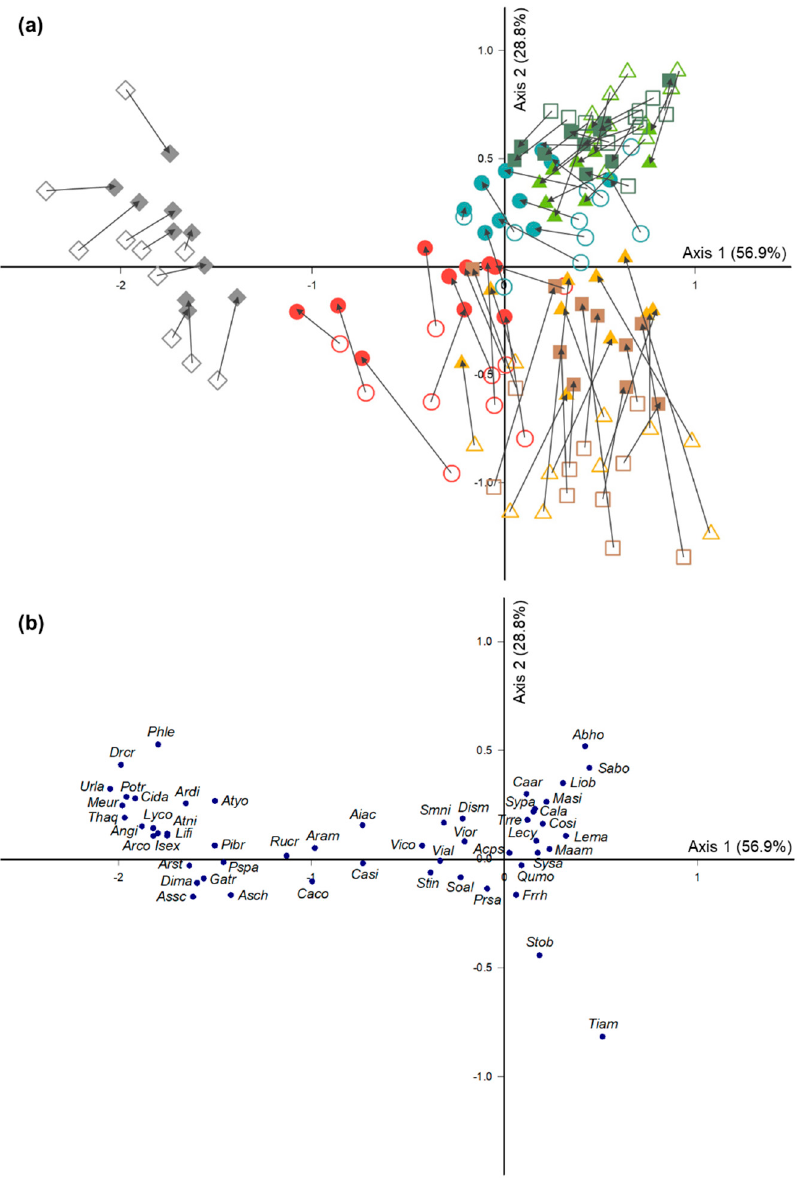
Figure 4. NMS ordination in the stands with seven understory types. ( a ) Stand ordination, ( b ) species ordination. The number next to each axis means the percentage of variance, and the stress of both axes was 0.12 ( n = 140). Species composition between 2017 (open symbol) and 2020 (closed symbol) is connected by a line with an arrow. Out of the 133 species that occurred in total, only 53 species with a total coverage of all plots (2017 and 2020) of 5% or more were presented. ● : FR (flowering and rooting), ▲ : FC (flowering and cutting), ■ : FI (flowering and intactness), ● : NR (non-flowering and rooting), ▲ : NC (non-flowering and cutting), ■ : NI (non-flowering and intactness), (cid:4) : Ref